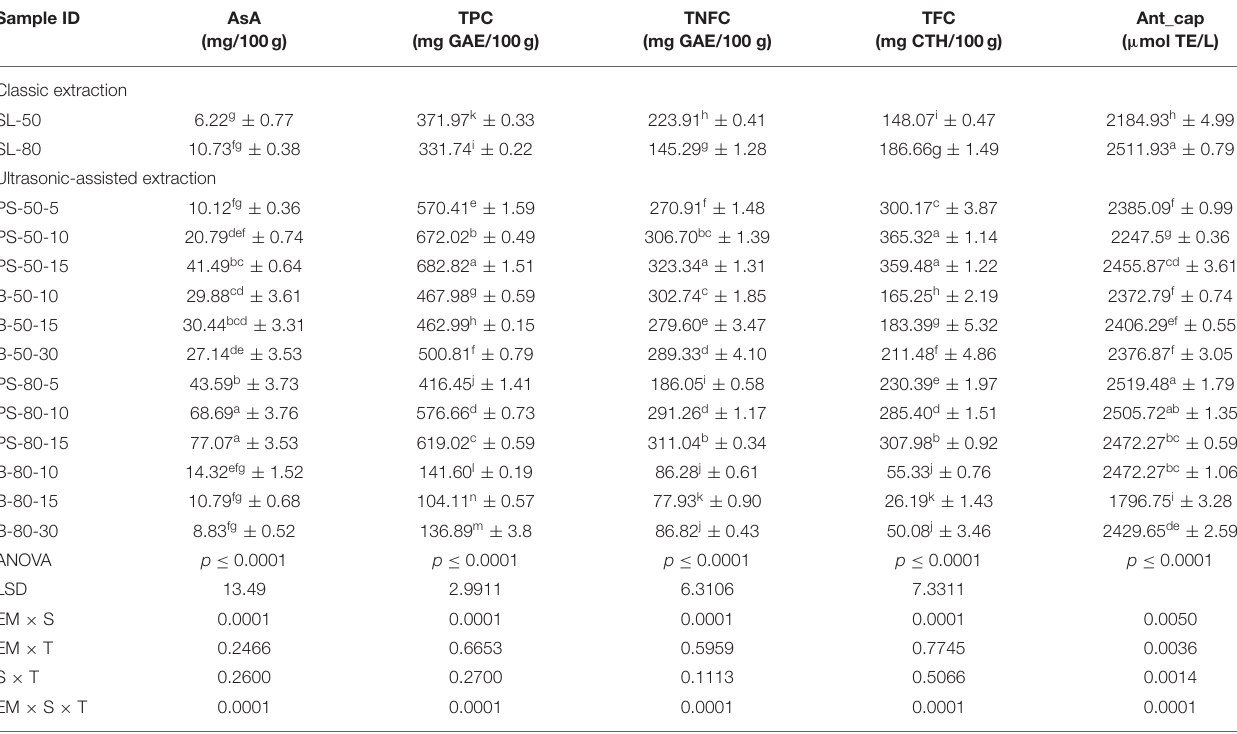
TABLE 2 | Specialized metabolites content of nettle alcoholic